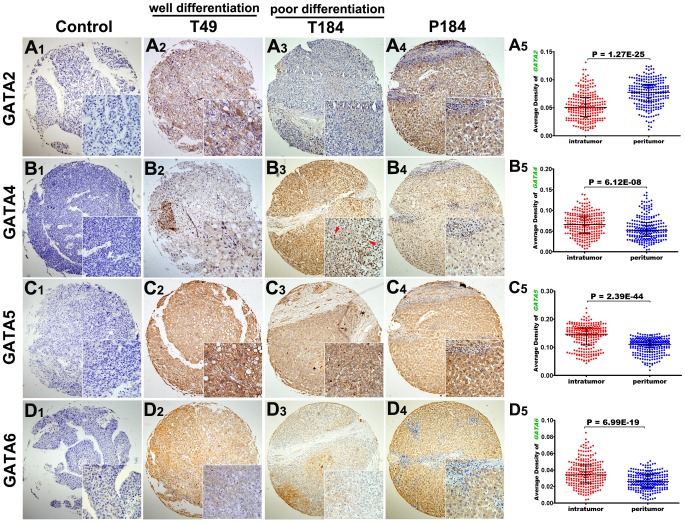
Representative images and quantitative density of GATAs in paired tumor and peritumor tissues from consecutive sections of tissue microarray (40× and 200×).Expression of GATA2 (A5) protein was decreased, GATA4 (B5), GATA5 (C5) and GATA6 (D5) was increased in tumor tissues compared with adjacent liver tissues. T49/T184 represented tumor tissues with well/poor differentiation state. P184 was the corresponding peritumor tissue of T184. Paired samples t tests for A5, B5, C5 and D5.